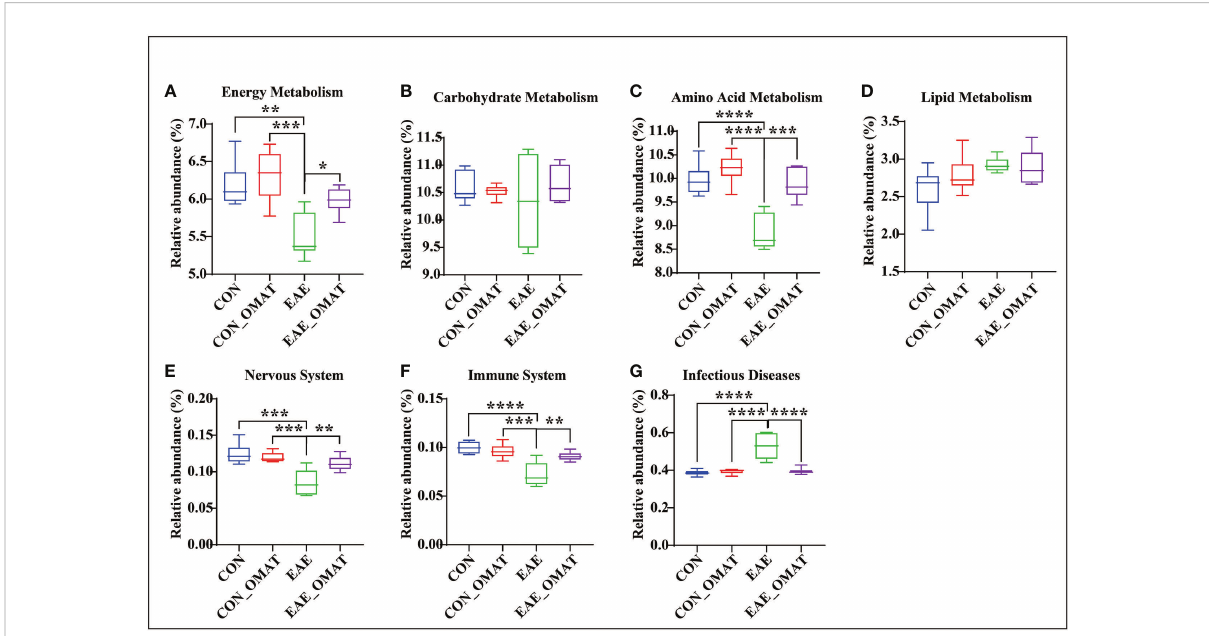
FIGURE 6 Comparison of the relative abundance of energy metabolism, nervous system, immune system, and infectious diseases based on KEGG analysis. Relative abundance of the KEGG orthologs belonging to Energy Metabolism (A) , Carbohydrate Metabolism (B) , Amino Acid Metabolism (C) , Lipid Metabolism (D) , Nervous System (E) , Immune System (F) , and Infectious Diseases (G) in the four mice groups. Data are expressed as the mean ± SD and statistical differences are represented by *, P < 0.05, **, P < 0.01, ***, and P < 0.001 based on Wilcoxon rank-sum test with the Benjamini – Hochberg method for multiple group